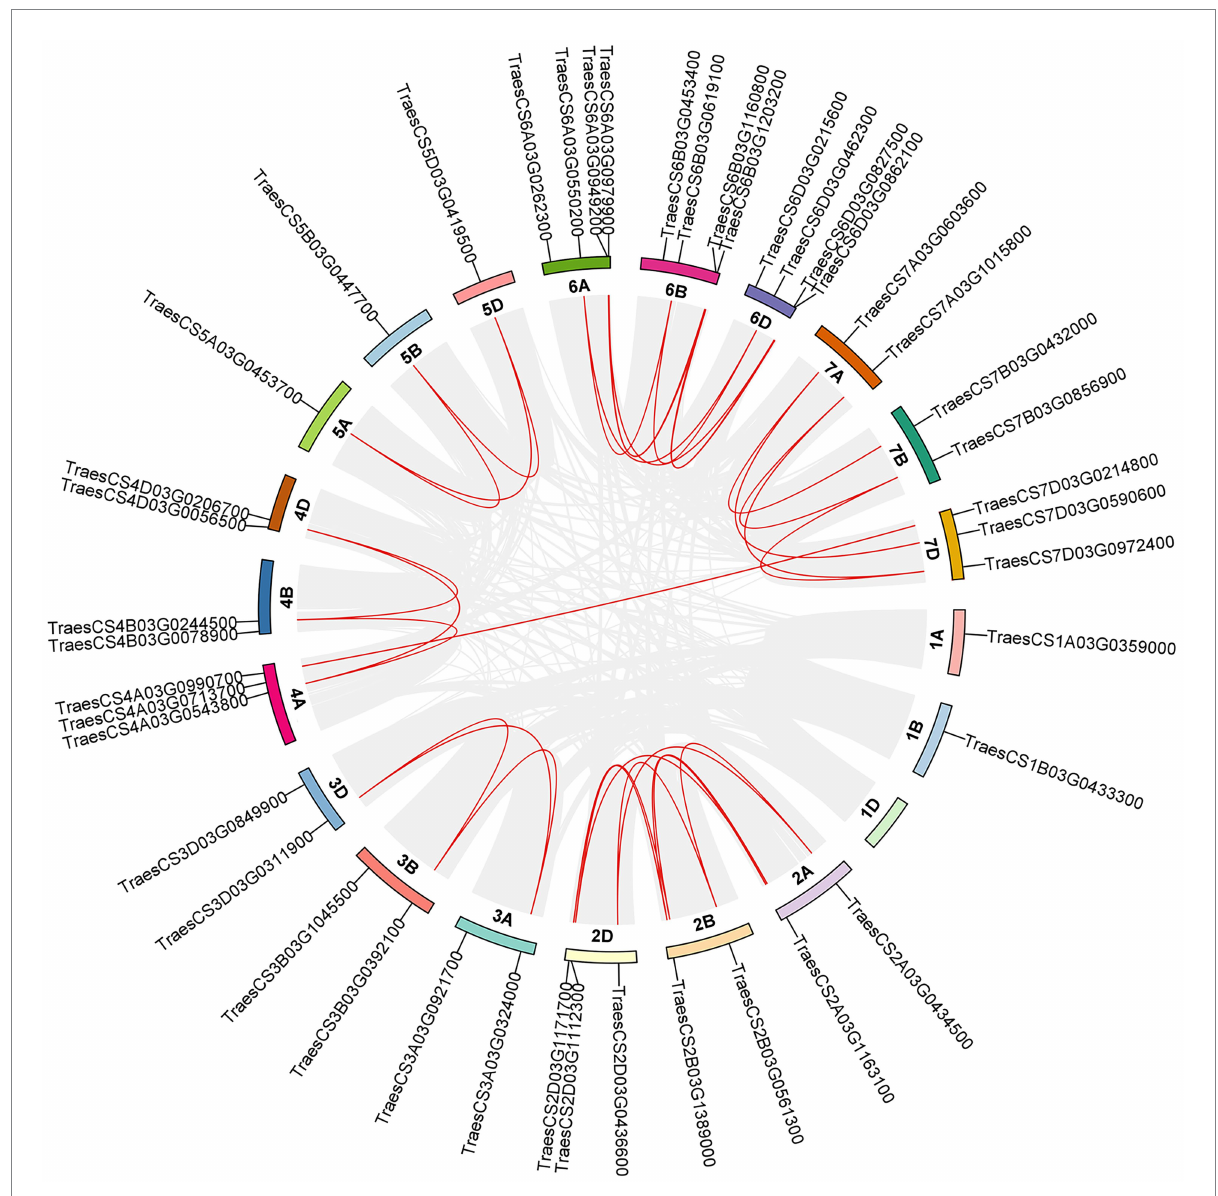
FIGURE 4 Distribution and collinearity of ABC1K gene family members in wheat chromosomes. The red lines represent the orthologous genes or tandem duplicated genes of TaABC1K and the gray lines represent the segmental duplication pairs in the whole wheat